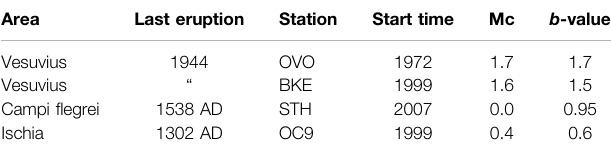
TABLE 1 | Parameters of the frequency-magnitude distribution ( b -value and Mc) of the three Neapolitan volcanic areas on the basis of single station catalogs. Area Last